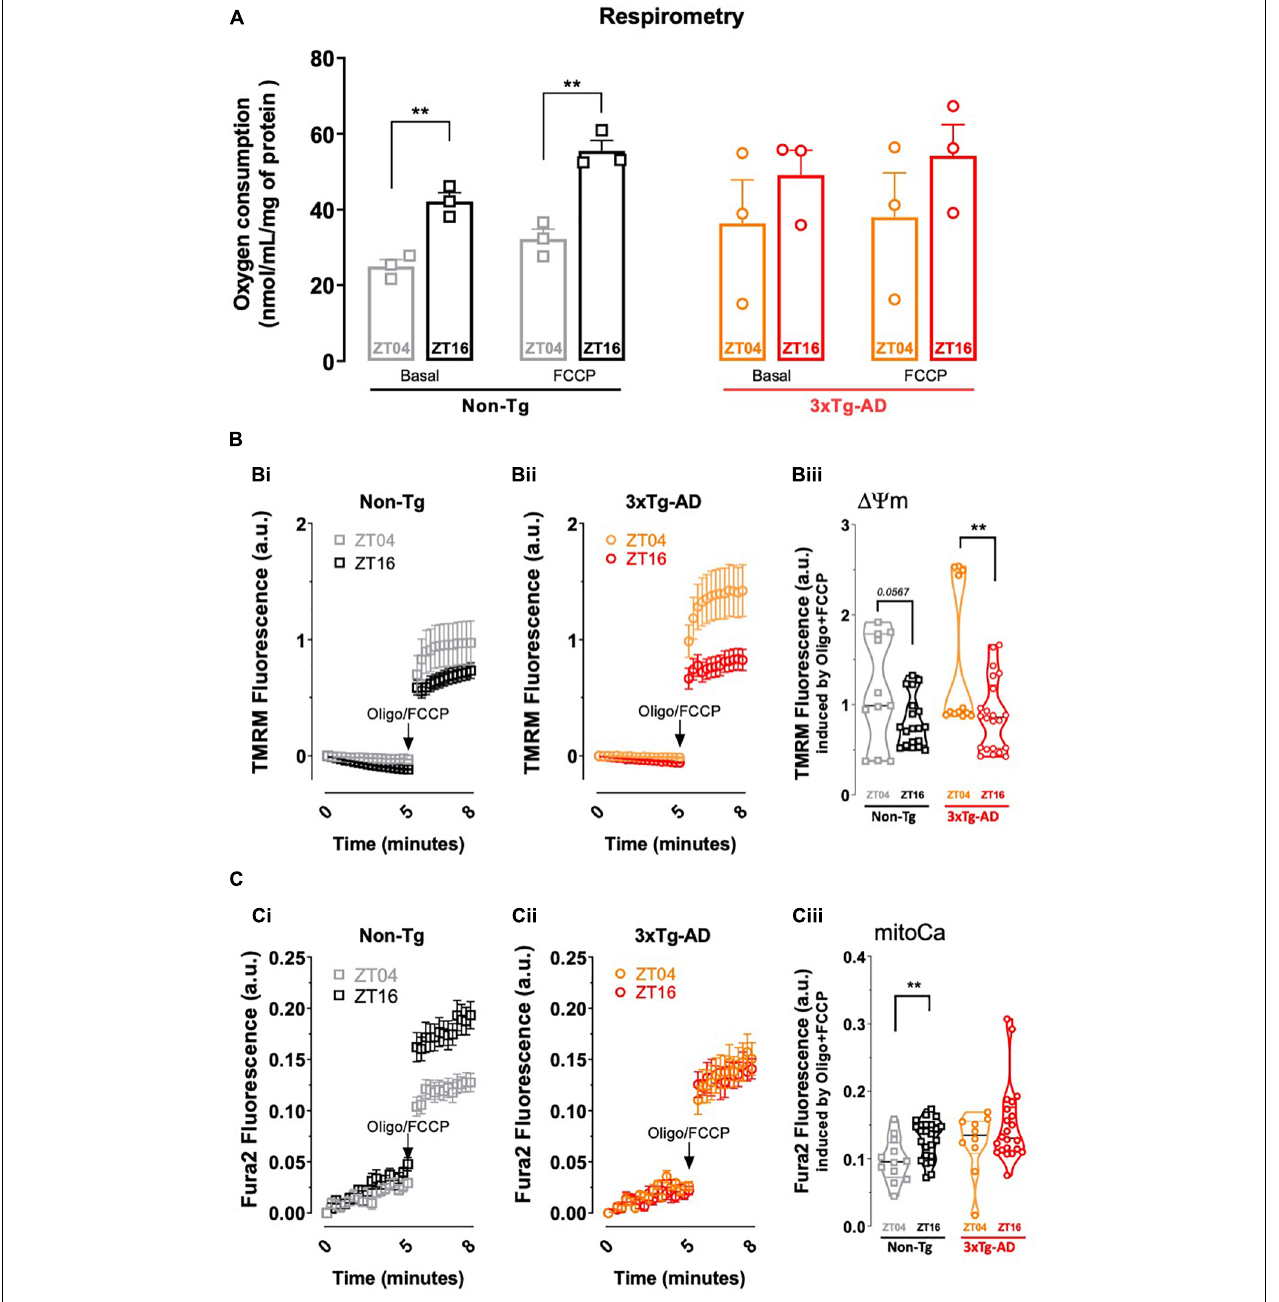
FIGURE 3 | Comparison of mitochondrial function in cortical synapses from non-Tg and 3xTg-AD mice collected near ZT04 (inactive phase) and ZT16 (active phase). (A) Oxygen consumption rates (OCR) in cortical synaptosomes isolated from 3xTg-AD vs. non-Tg mice, at ZT04 and ZT16, where the first set of bars represents basal and FCCP induced-OCR at the two ZT’s for non-Tg mice, and the second set of bars represents the same parameters for 3xTg-AD animals. Non-Tg animals display a circadian variation of both basal and FCCP-induced OCR, which is absent in 3xTg-AD. (B) Fluorometric analysis of mitochondrial membrane potential in cortical synaptosomes from non-Tg (Bi) and 3xTg-AD mice (Bii) at ZT04 and ZT16, depicted by the representative trace of TMRM + fluorescence. Quantification of TMRM + fluorescence after complete mitochondrial depolarization achieved by addition oligomycin plus FCCP shows a circadian variation for 3xTg-AD animals and a tendency in non-Tg mouse synaptosomes (Biii). (C) Fluorimetric analysis of mitoCa retention in cortical synaptosomes from non-Tg (Ci) and 3xTg-AD (Cii) mice at ZT04 and ZT16, depicted by the representative traces of Fura2 fluorescence. Quantification of Fura2 fluorescence following addition of oligomycin plus FCCP shows a circadian variation in non-Tg that is not observed in 3xTg-AD mouse synaptosomal mitochondria (Ciii). Data are presented as the mean ± SEM, n = 3–4 mice, each run in triplicates. Statistical analysis: ** p < 0.01 vs. other ZT, using a Student’s t -test.